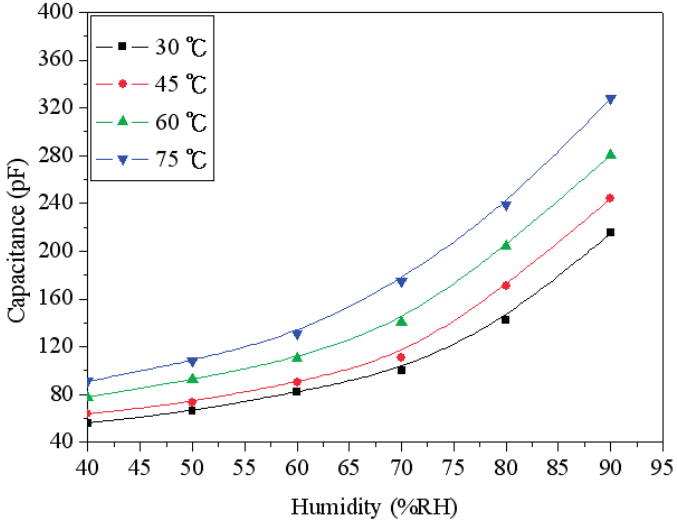
Figure 9. Measured capacitance of the humidity sensor at different temperatures.